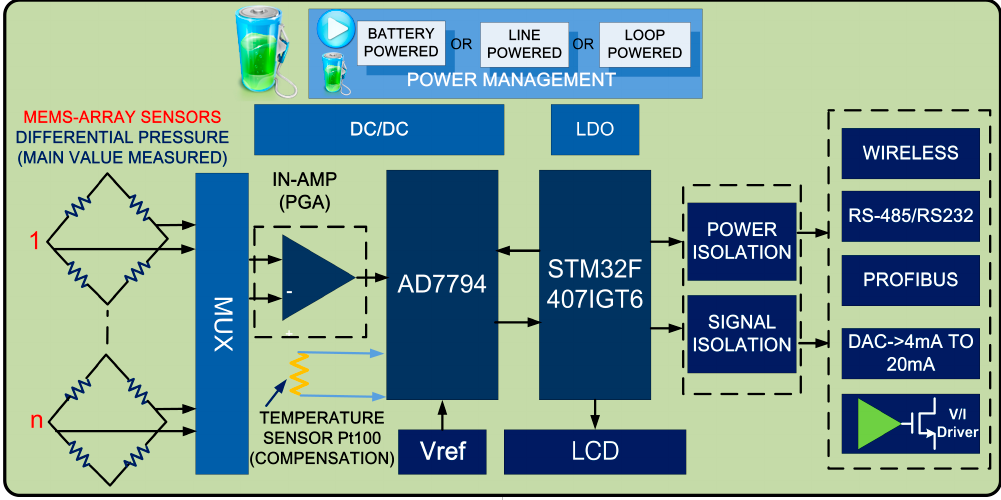
Figure 1. System block diagram for the digital MEMS-array pressure transmitter and the hardware is implemented by using the sensor array and